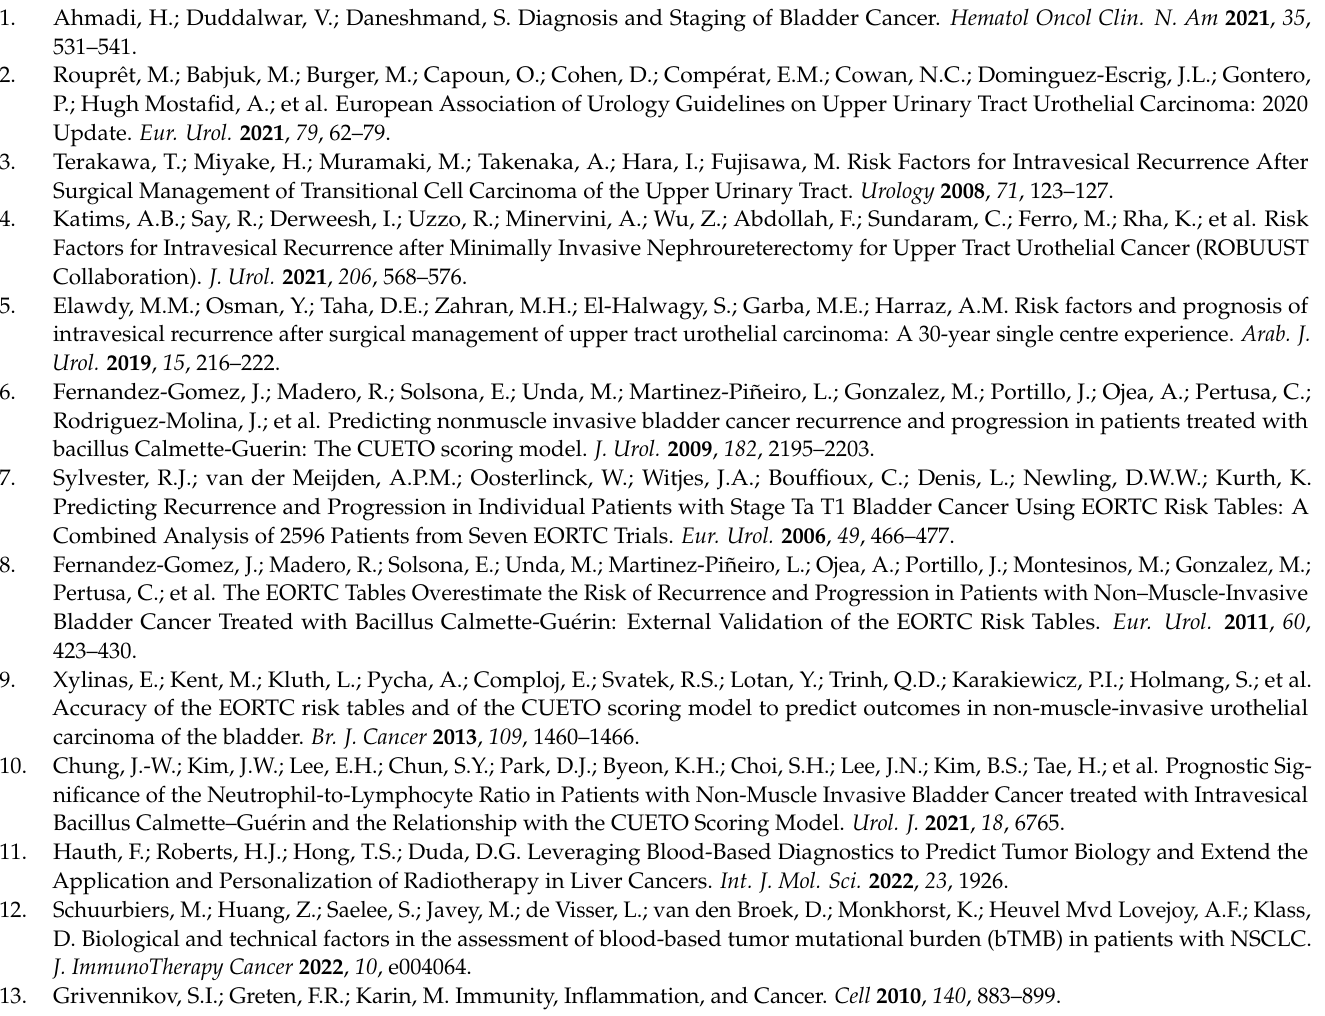
Figure S3. Sensitivity analysis of the effect of modified Glasgow prognostic score on recurrence free survival in urothelial carcinoma: (A) mGPS 1 vs. 0; (B) mGPS 2 vs. 0. Figure S4. Sensitivity analysis of the effect of modified Glasgow prognostic score on cancer specific survival in urothelial carcinoma: (A) mGPS 1 vs. 0; (B) mGPS 2 vs. 0; (C) mGPS high vs.